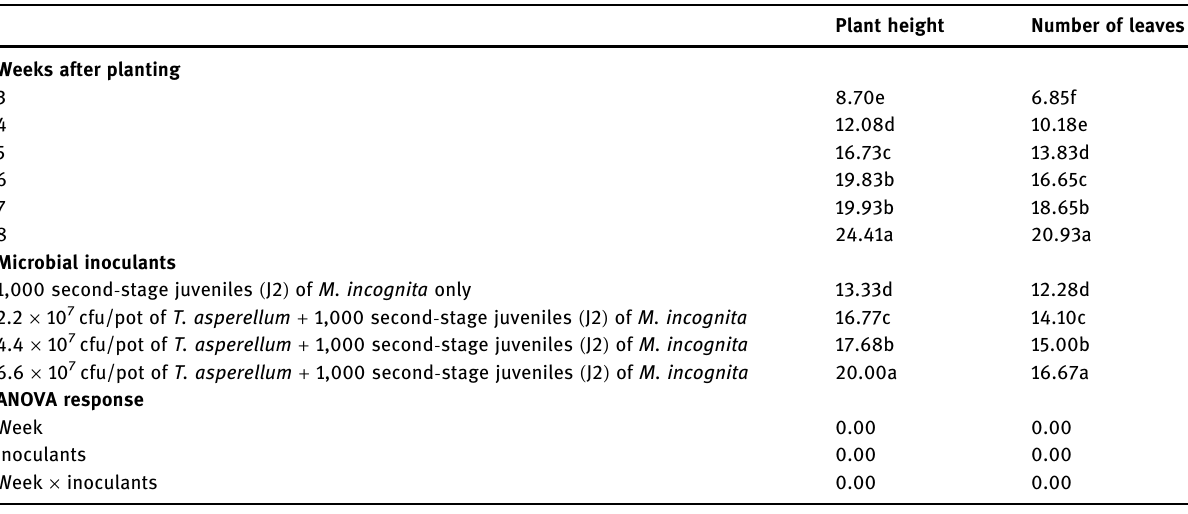
Plant height Number of leaves